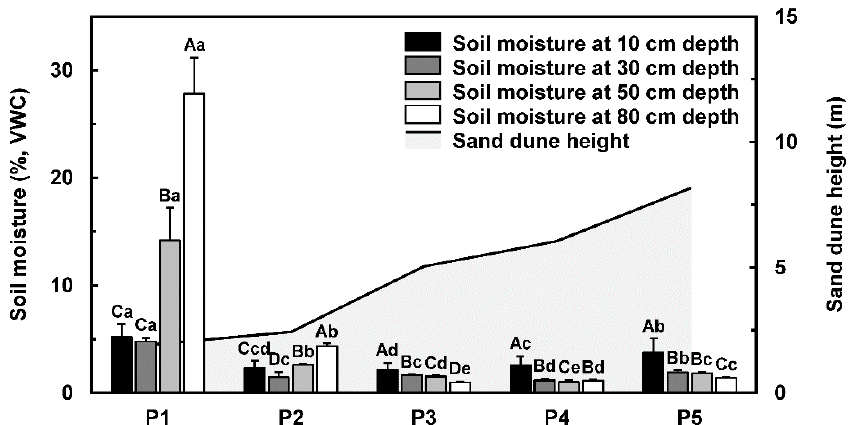
Figure 2. Moisture contents at different soil depths according to changes in sand dune height, from July to September 2018. Values with different capital letters indicate significant differences among four soil depths in each measurement point (Dunnett’s T3 test, p ≤ 0.05). Values with different small letters denote significant differences among five measurement points in each soil depth (Dunnett’s T3 test, p ≤ 0.05). Soil moisture data at 50 cm in P1 was not available from July to September 2018, so data from 2017 was used for the same period.